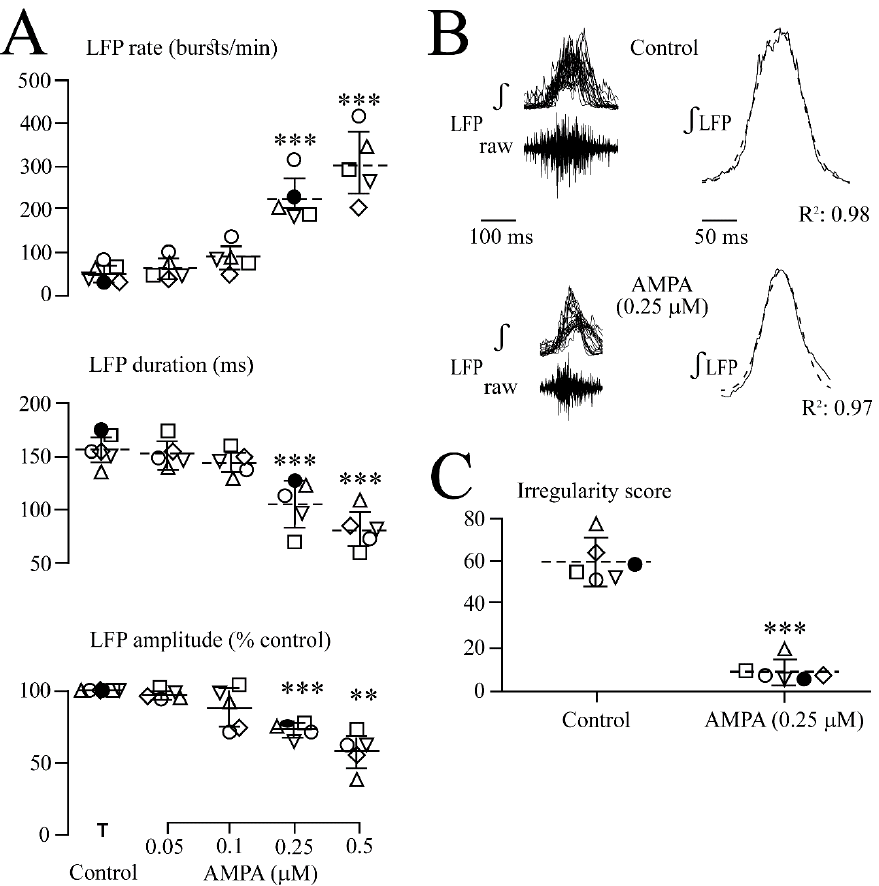
Figure 2. Quantification of AMPA effects on LFP. ( A ) Analysis in five slices (each represented by the same symbol) revealed that the LFP burst rate (upper plots) increased and single event duration (middle plots) and integrated trace amplitude (lower plots) decreased at 0.25 and 0.5 µM. ( B ) Overlay and subsequent averaging of five subsequent bursts from four of the slices in ( A ) revealed a bell- shaped LFP envelope during both the control and 0.25 µM AMPA with a Gaussian fit of R 2 = 0.98 and R 2 = 0.97, respectively. ( C ) In six different slices (each represented by the same symbol), 0.25 µM AMPA reduced the irregularity score indicating that rhythm became more regular. The lines indicate mean values (dotted line) ± SD (solid lines); significance (** p < 0.01, *** p < 0.001) was determined with one-way ANOVA with Dunnett’s post-test in ( A ) (F(1, 5) = 29.64, p < 0.0001) (upper plots), (F(1, 5) = 20.42, p < 0.0001) (middle plots) and (F(1, 5) = 20.58, p < 0.0001) (lower plots) and two-tailed paired t-test in ( C ).